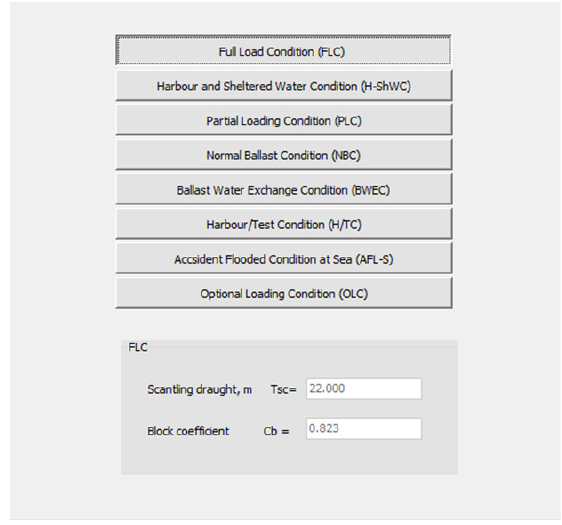
Figure 17. Ship load cases.